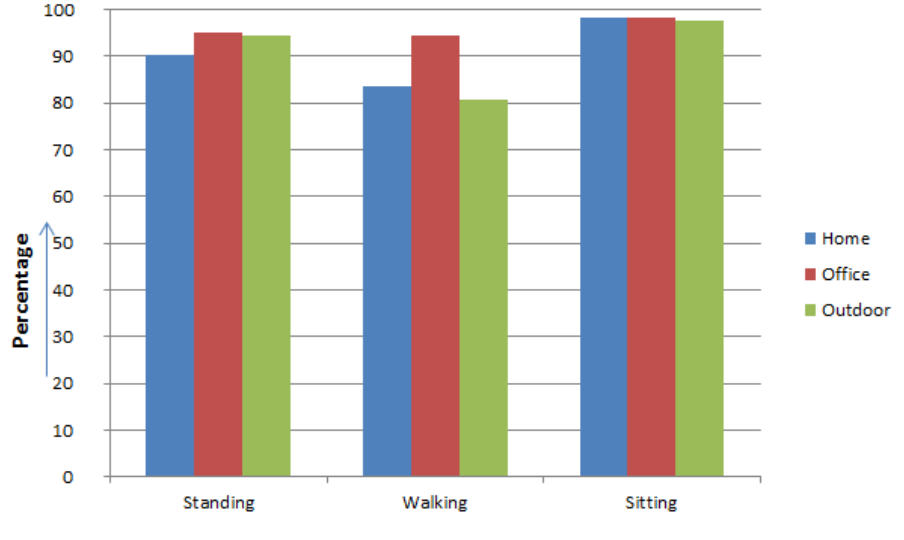
Figure 7. Activity Recognition accuracy in different